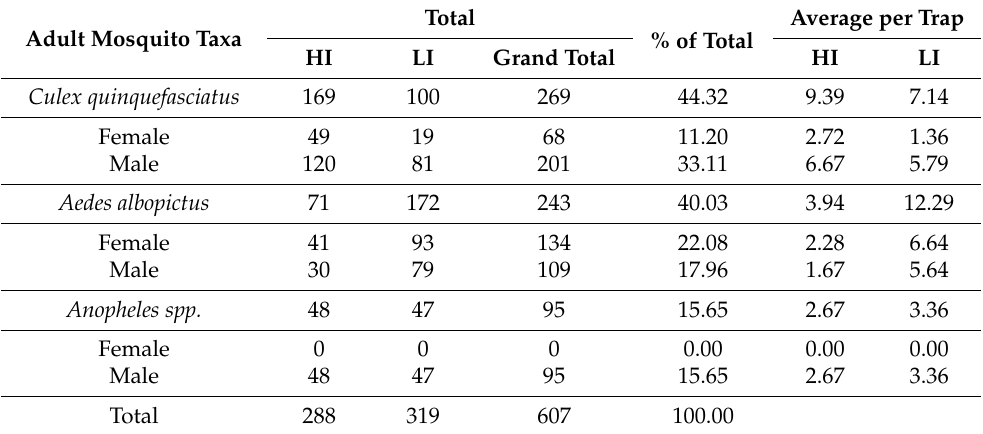
Table 3. Adult mosquito survey results by neighborhood (HI: high-income; LI: low-income). Total Average per Trap Adult Mosquito Taxa % of Total HI LI Grand Total HI Culex